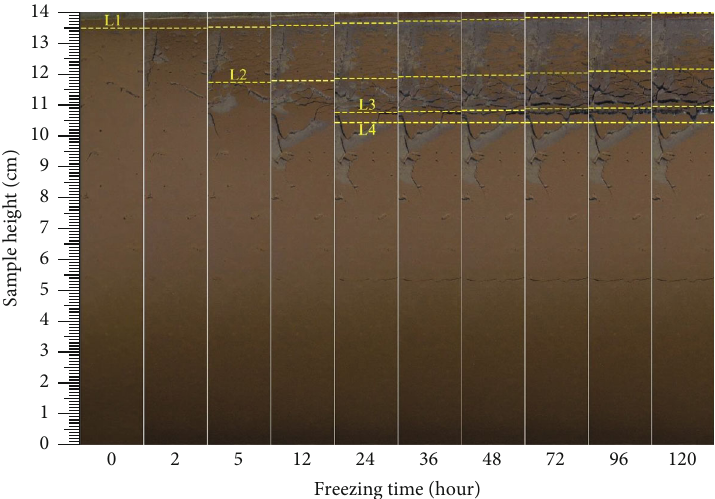
Figure 4: The cryostructure in the vertical pro fi le of the sample SW1.